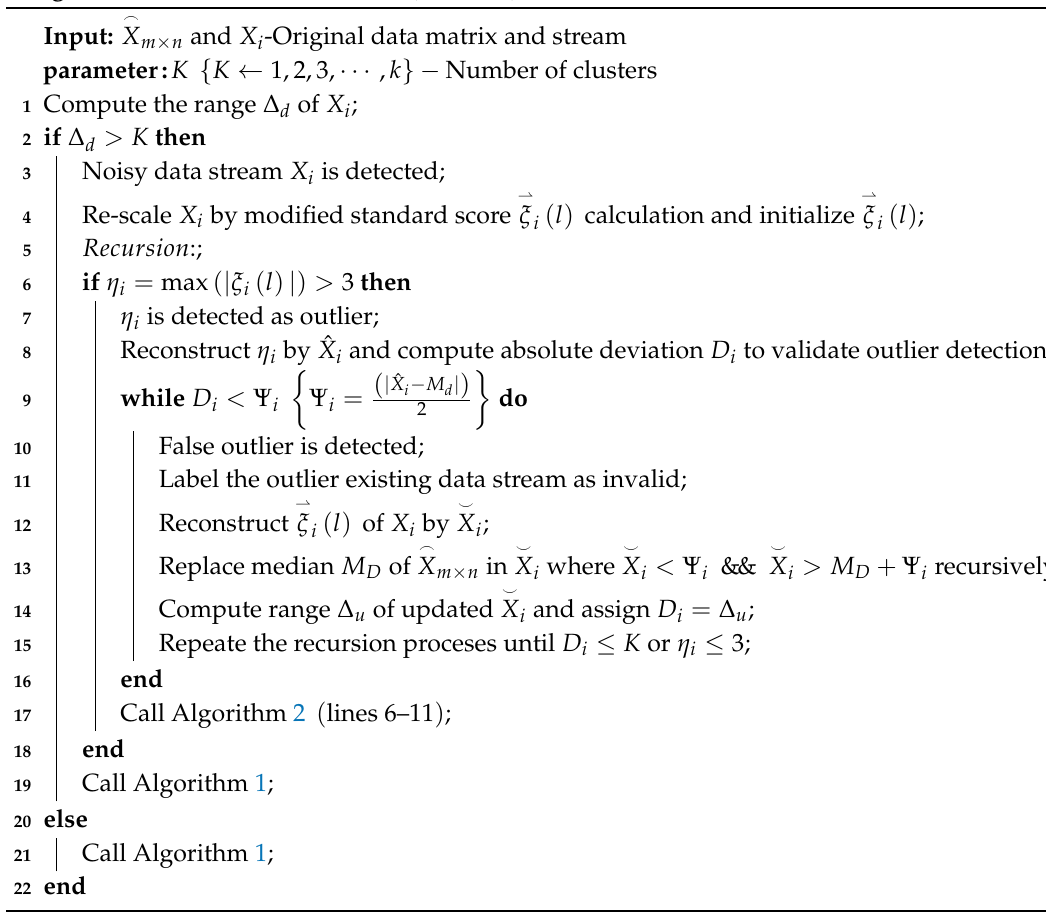
Algorithm 3: Verification of RODS (V-RODS) with